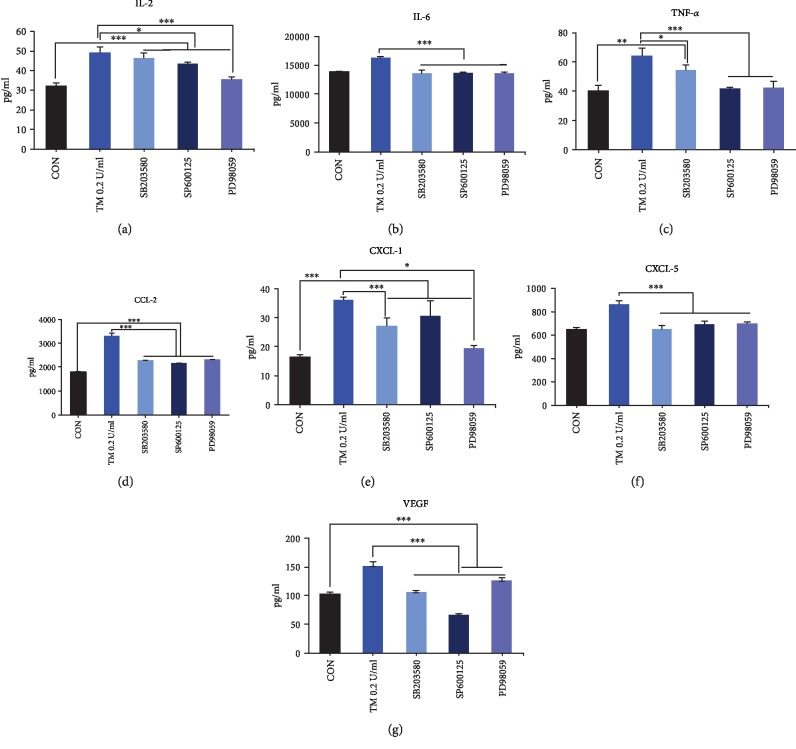
Effect of cell signaling inhibitors including selective P38 MAPK inhibitor (SB203580), ERK1/2 MAPK inhibitor (PD98059), and JNK pathway inhibitor (SP600125) on thrombin-induced releasing of mediators of P815 cells. Selective P38 MAPK inhibitor (SB203580), ERK1/2 MAPK inhibitor (PD98059), and JNK pathway inhibitor (SP600125) lessen, but not completely, the mediators released by P815 cells induced by thrombin. ANOVA was performed. Multiple comparisons were applied to compare the difference between cell signaling inhibited groups and the thrombin group or control group. ∗ means that the difference was statistically significant between groups; ∗P < 0.05, ∗∗P < 0.01, and ∗∗∗P < 0.001. Difference between the control group and the thrombin group is shown in Figure 3. CON: control group; TM: thrombin.